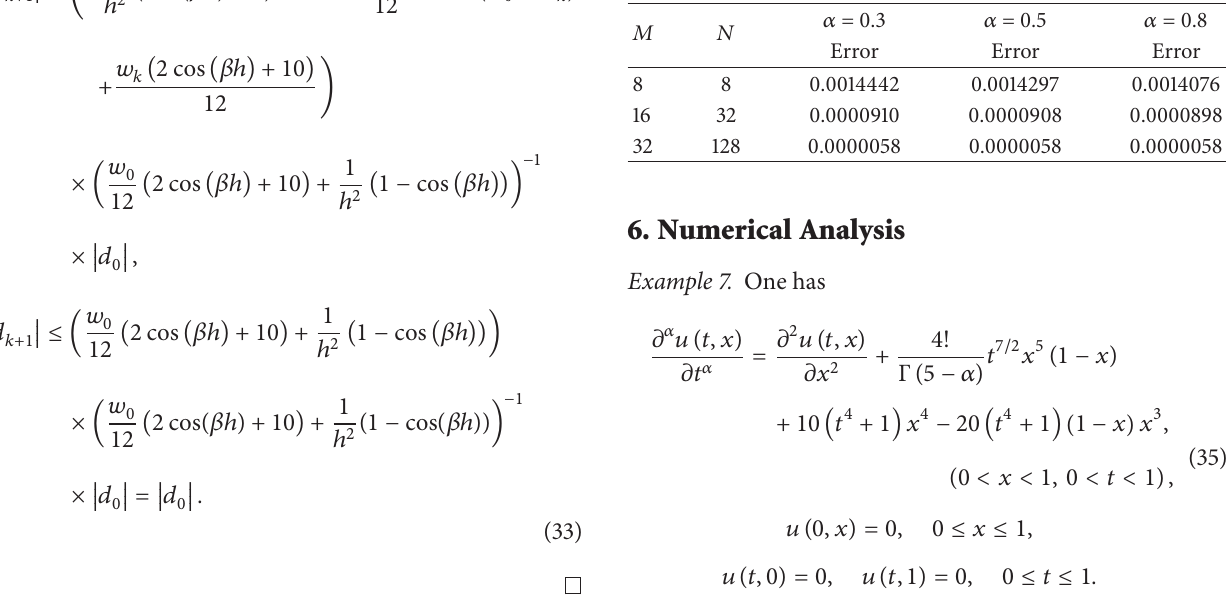
Table 1: Error table for Example